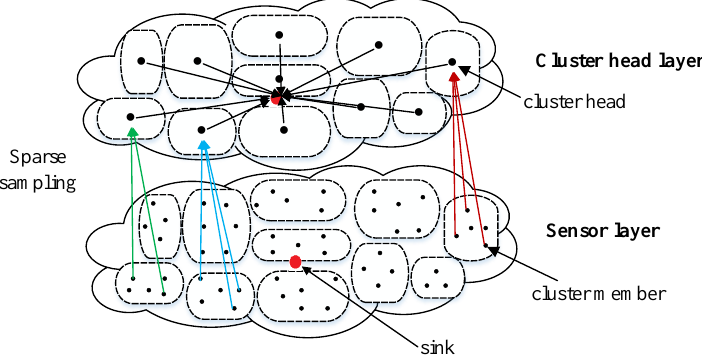
Figure 1. The sparse sampling data gathering scheme in wireless sensor networks